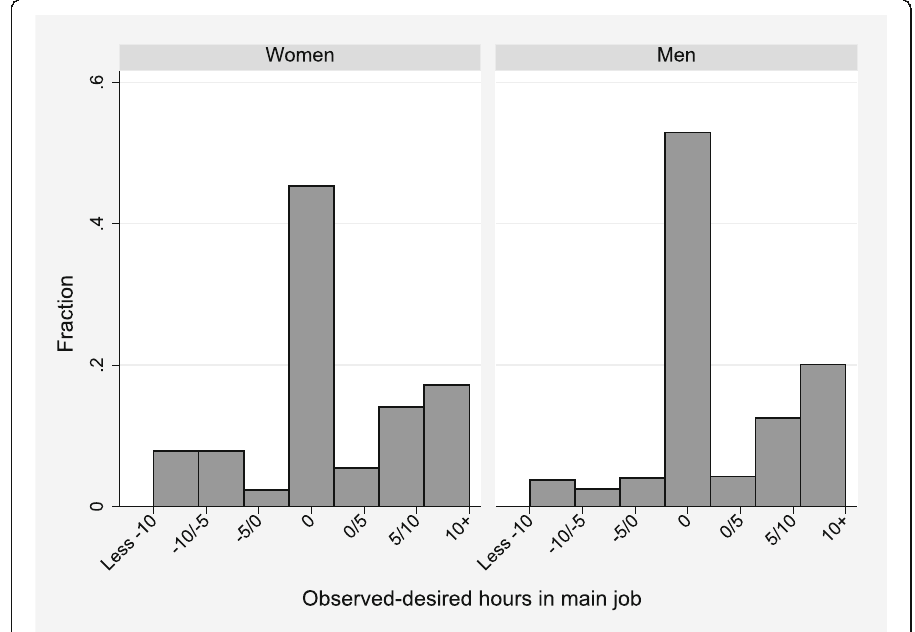
Fig. 5 Distribution of difference between observed and desired hours for workers. Notes: 527 observations: 128 women and 399